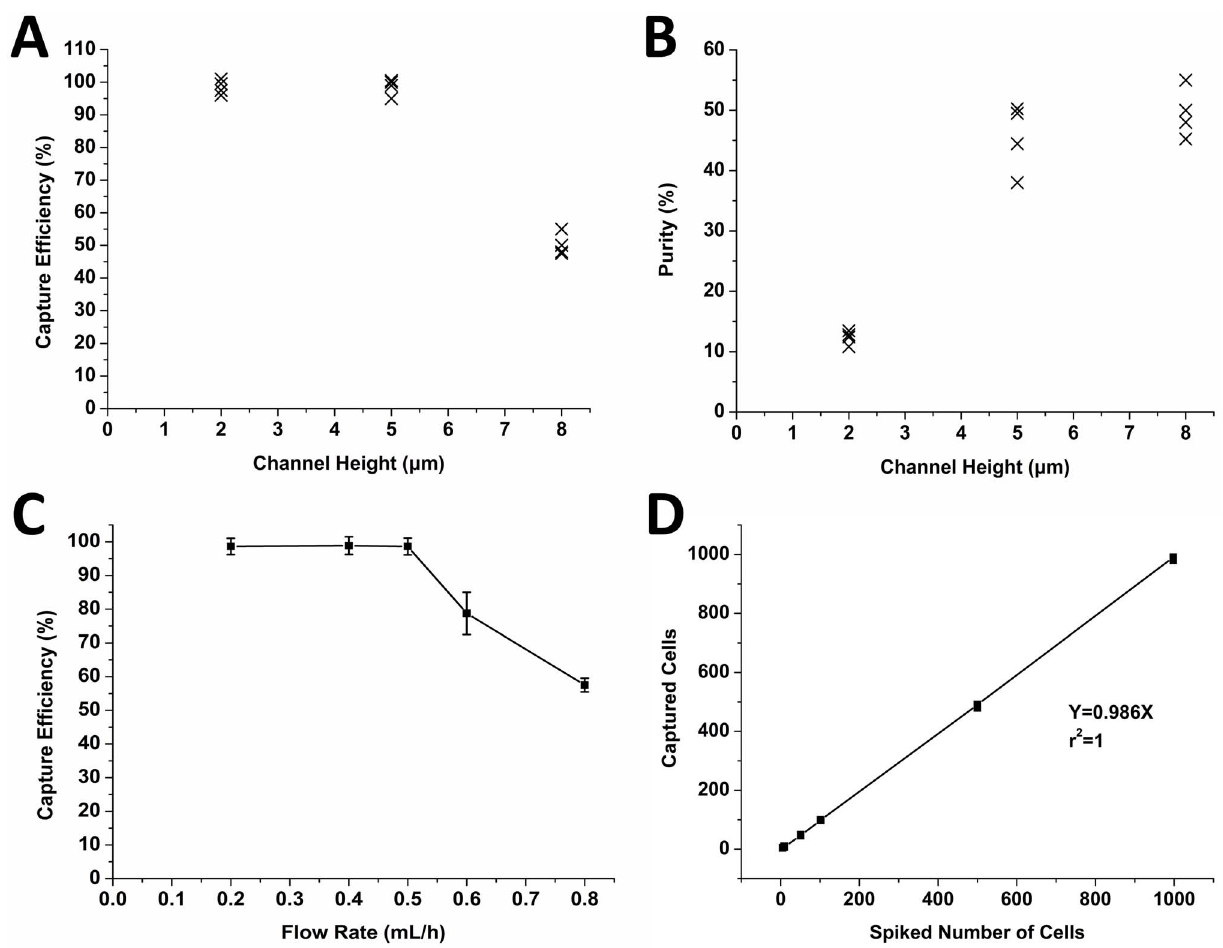
Figure 2. The parameter optimization of the microdevice and recovery rate of tumor cells. A) The relationship between channel height and capture efficiency: The capture efficiency was calculated by dividing the number of the target cells captured by the number of the target cells introduced into the device. B) The relationship between channel height and cell purity: The purity of cells captured was determined by dividing the number of the target cells captured by the number of the total cells captured. The flow rate was 0.5 mL/h for A) and B). C) The relationship between flow rate and capture efficiency: The capture efficiency was calculated by dividing the number of the target cells captured by the number of the target cells introduced into the device. The channel height was 0.5 m m. The error bars represented one standard deviation of 4 repeat experiments. D) Recovery of known numbers of spiked HT-29 cells from whole blood. Regression analysis of observed tumor cells number versus expected tumor cells number produced a slope of 0.986 and a correlation coefficient (R 2 ) of 1.